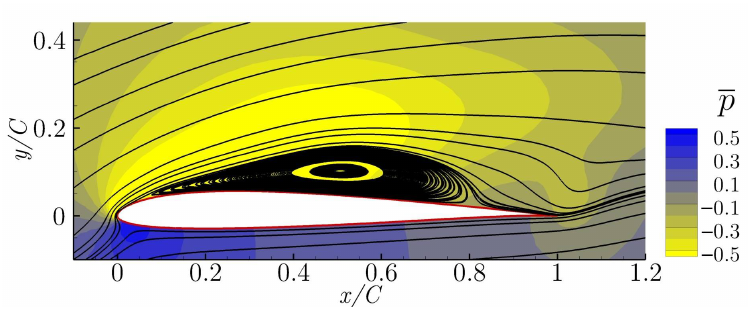
Figure 6. Averaged streamlines and pressure field of case 2 ( C l = 1.39).